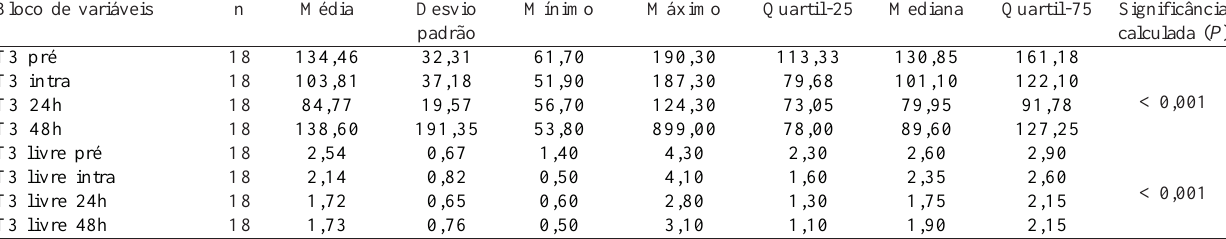
Bloco de variáveis